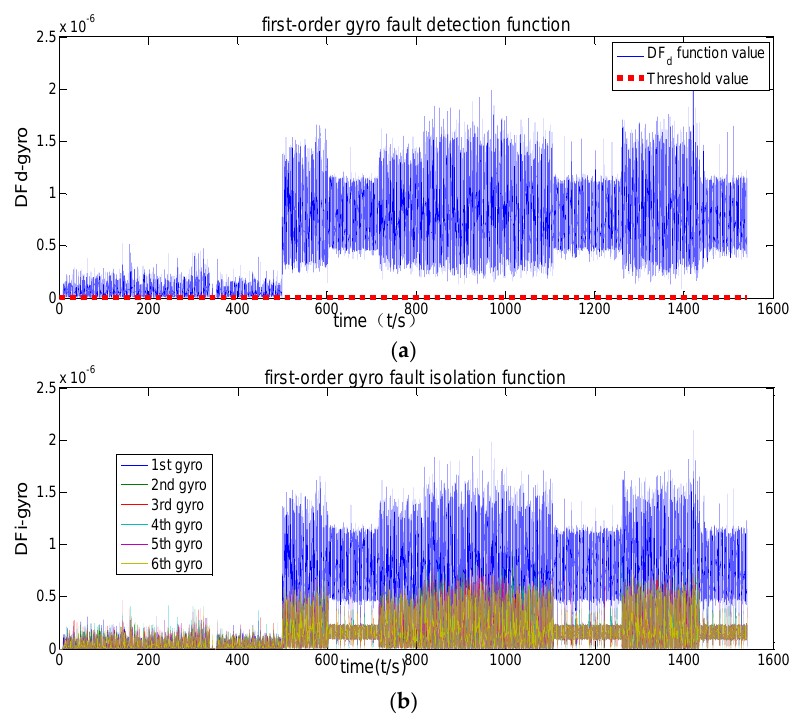
Figure 6. First-order channel filter (the fault amplitude is 5 ◦ /h). ( a ) Fault detection; ( b ) Fault isolation.